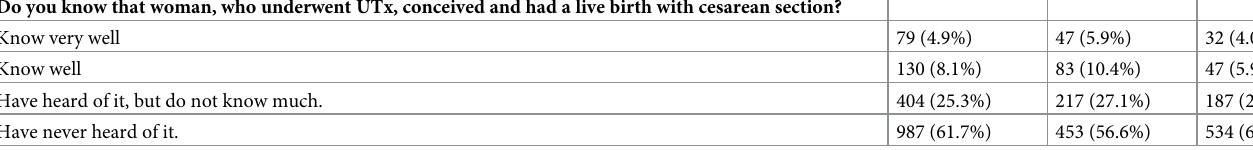
Table 2. The comparison of public attitude towards UTx and gestational surrogacy among various age and gender.